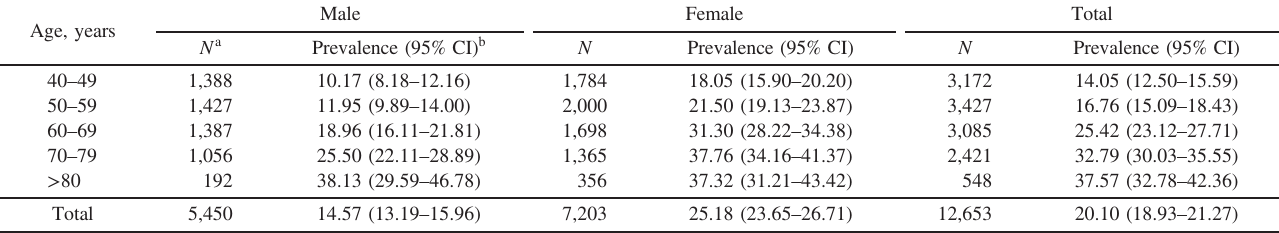
Table 1. Prevalence of dizziness by sex and age group in participants over 40 years old ( n = 12,653)